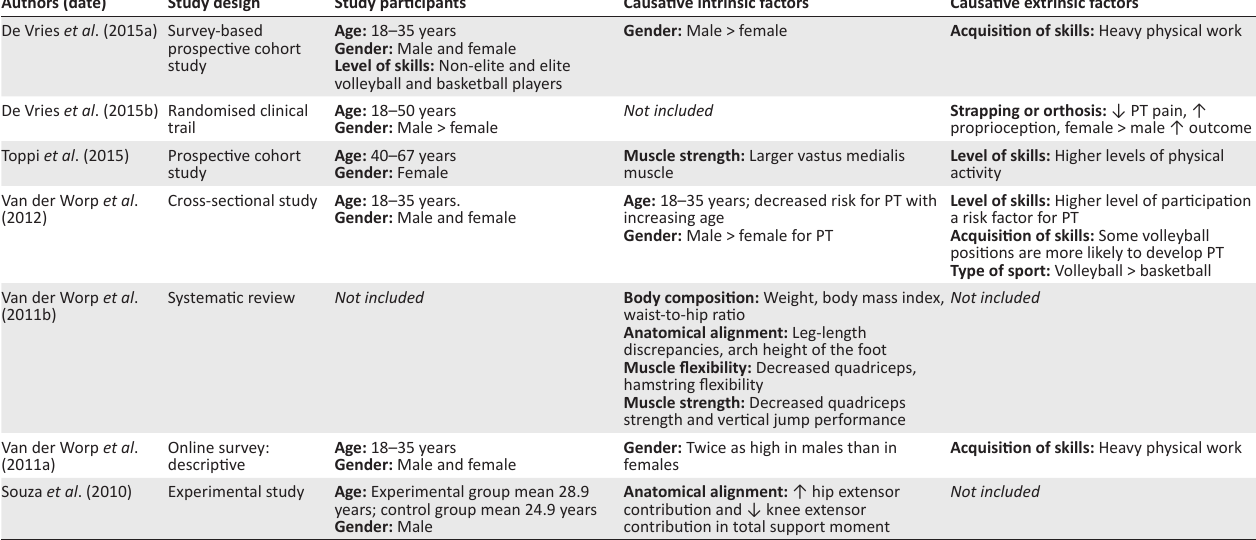
TABLE 2: The intrinsic and extrinsic causative factors for PT in the articles included in the review. Authors